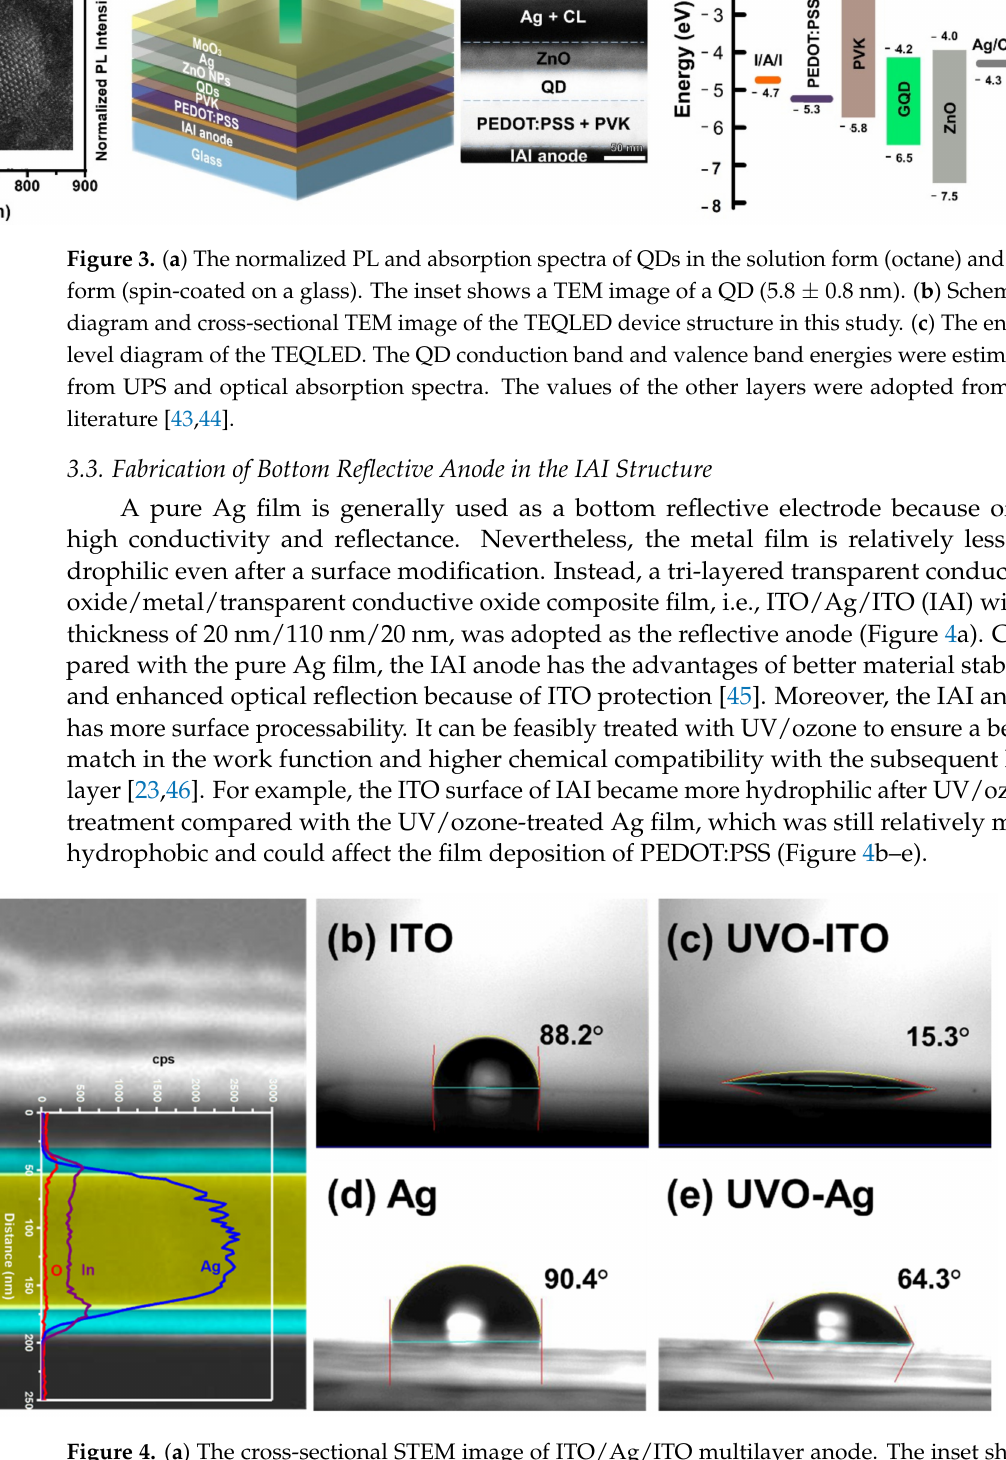
Figure 4. ( a ) The cross-sectional STEM image of ITO/Ag/ITO multilayer anode. The inset shows the corresponding EDS line scan profile. The contact angle of water on ( b ) ITO, ( c ) UVO-treated ITO, ( d ) Ag, and ( e ) UVO-treated